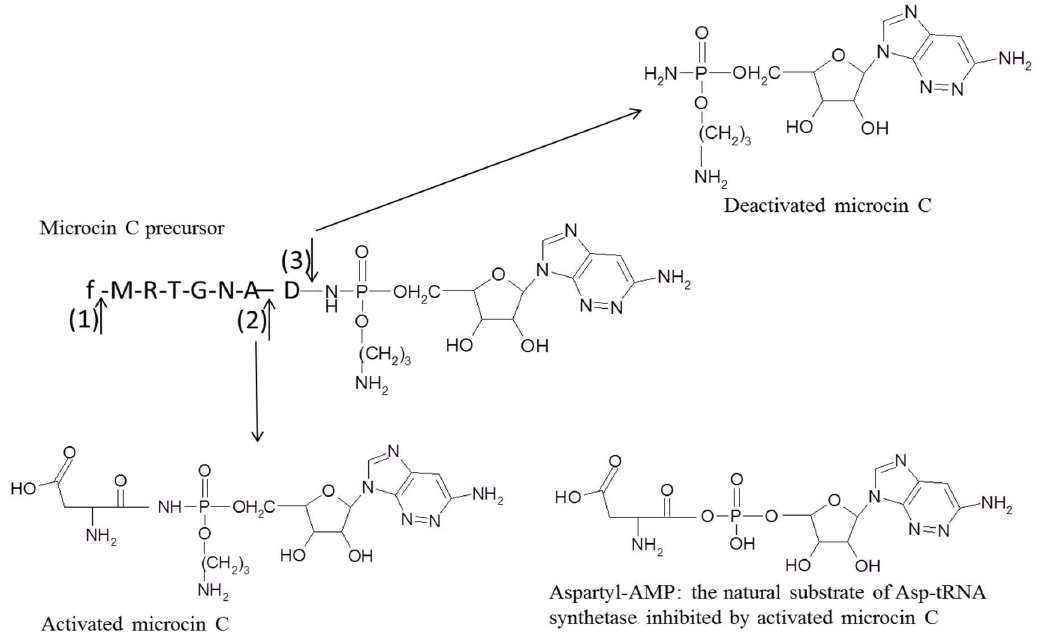
Figure 6. Structure of microcin C precursor and site of cleavage by deformylase (1), aminopeptidases enzymes (2) and serine proteases (3). Microcin C is double processed in bacterial targeted cells, first by deformylase and then by specific aminopeptidase, releasing the active microcin C which is an aspartyl-AMP analogue that competes with this natural substrate and inhibits tRNA-synthetase in sensitive strains. Specific serine proteases can deactivate microcin C in some resistant strains.